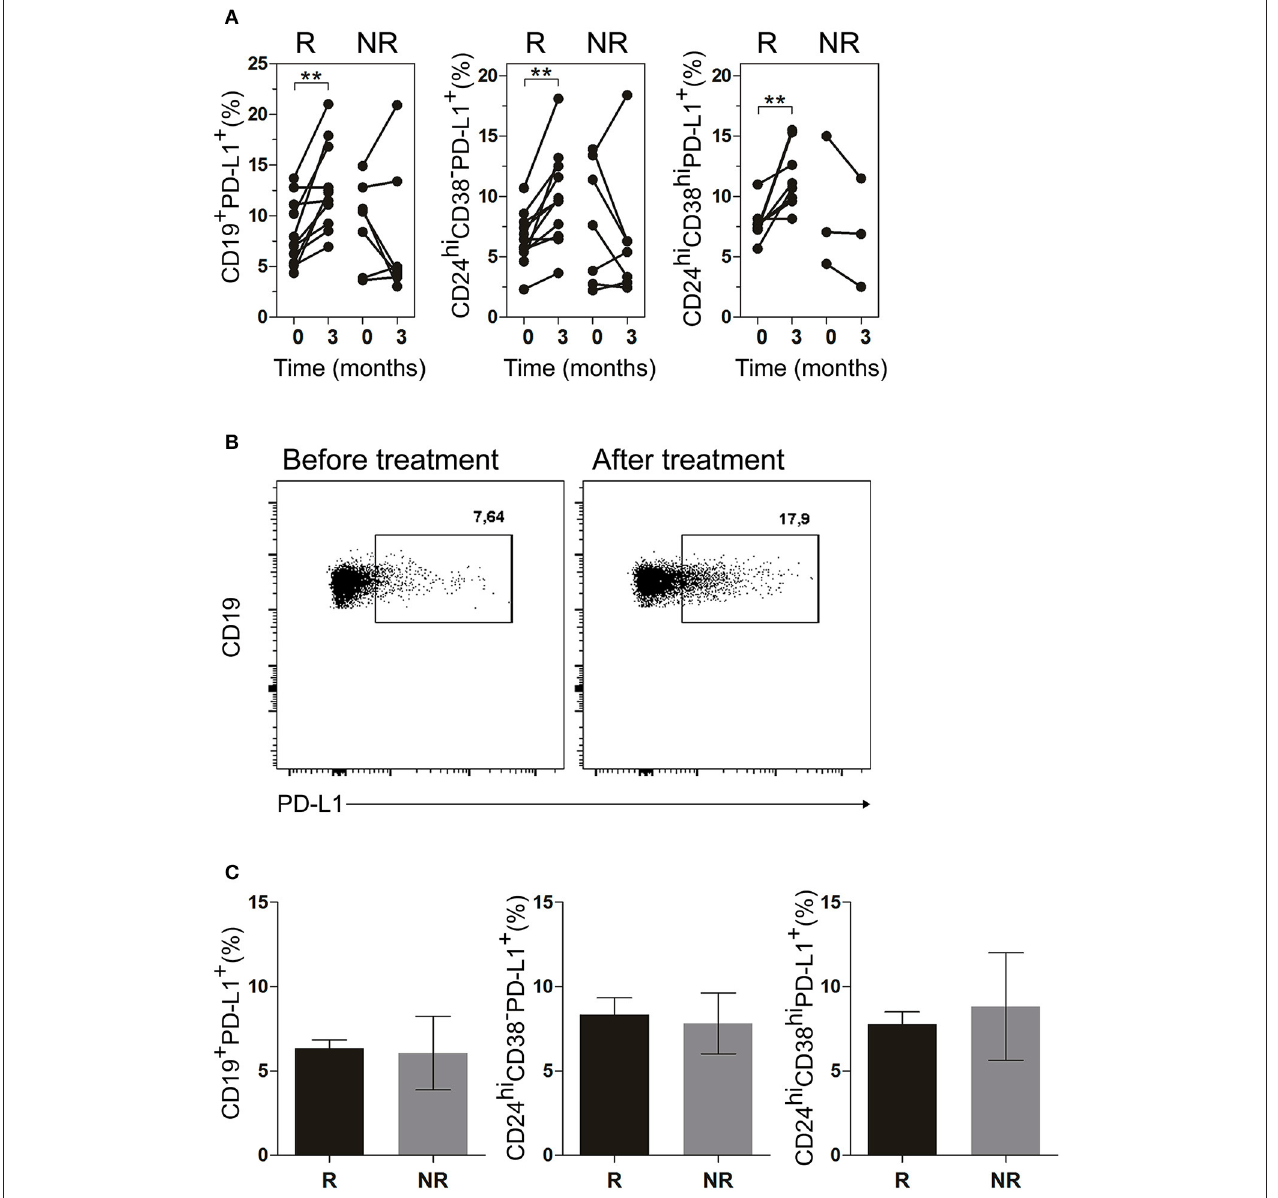
FIGURE 6 | CD19 + PD-L1 + , CD24 hi CD38 − PD-L1 + and CD24 hi CD38 hi PD-L1 + B cells were increased in peripheral blood of good responder patients. (A) Frequencies of CD19 + PD-L1 + B cells, CD24 hi CD38 − PD-L1 + and CD24 hi CD38 hi PD-L1 + B cells at baseline (time 0) and after 3 months (time 3) of different treatments in good responders (R, n = 11) and non-responders (NR, n = 7) patients. (B) Representative dot plot of PD-L1 + vs CD19 + B cells in a R patient, at baseline and after 3 months of treatment. Flow cytometry analysis was performed on lymphoid cells. ** p < 0.01. P values were determined using the Student’s t -test for paired samples. (C) Frequencies of CD19 + PD-L1 + B cells, CD24 hi CD38 − PD-L1 + and CD24 hi CD38 hi PD-L1 + B cells at baseline (time 0) in good responder (R, n = 11) and non-responder (NR, n = 7) patients. Data are expressed as mean ± SEM. Student’s unpaired t -test was